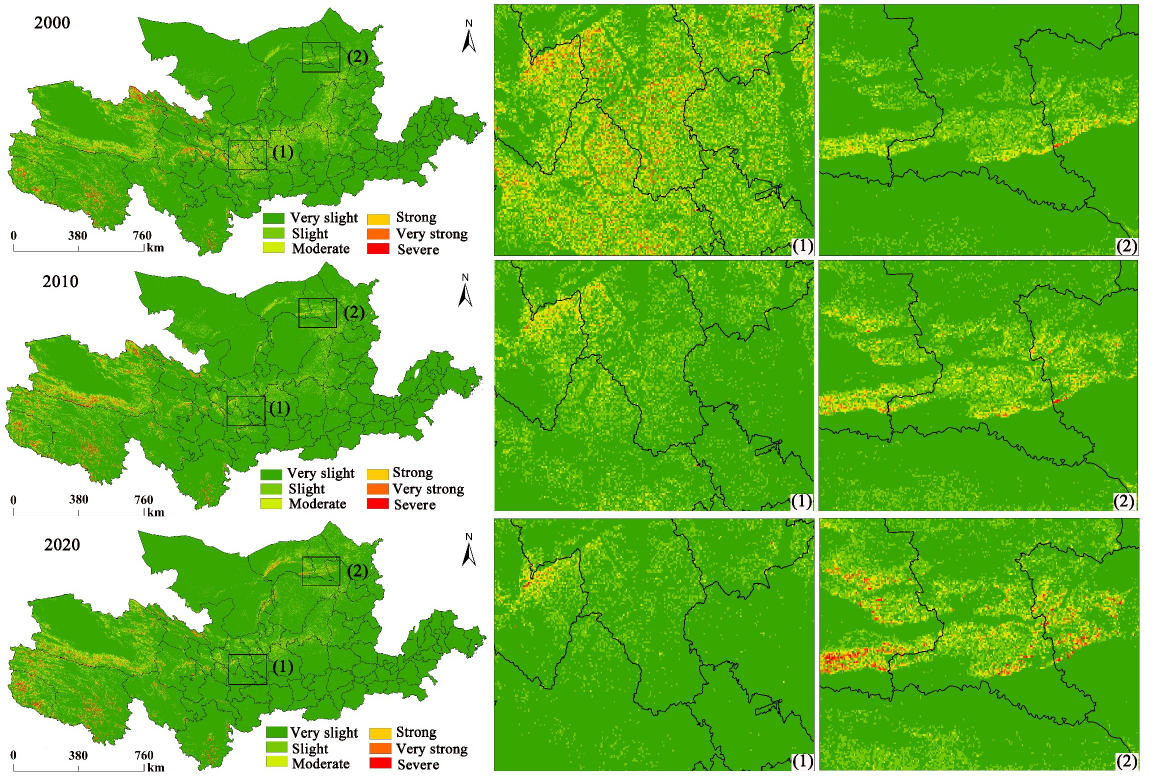
Figure 3. SE spatial distribution from 2000 to 2020. (1) and (2) represent two randomly selected areas of significant change. of significant